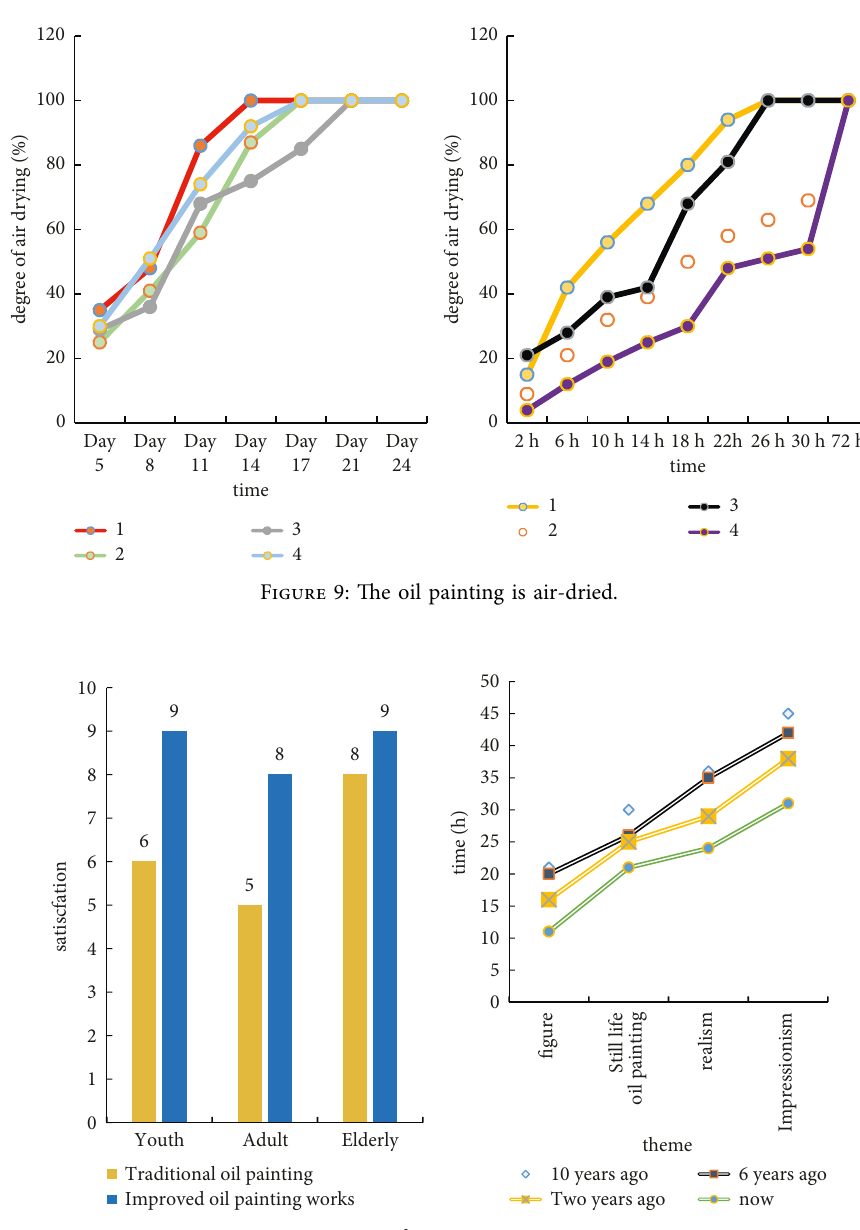
Figure 10: Satisfaction survey